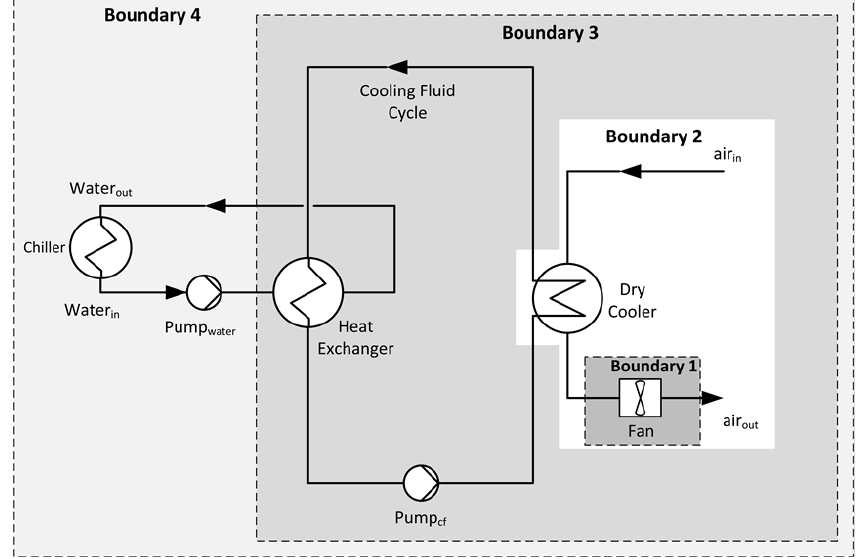
Figure 3. System boundaries for electric power in monitoring projects. Boundary